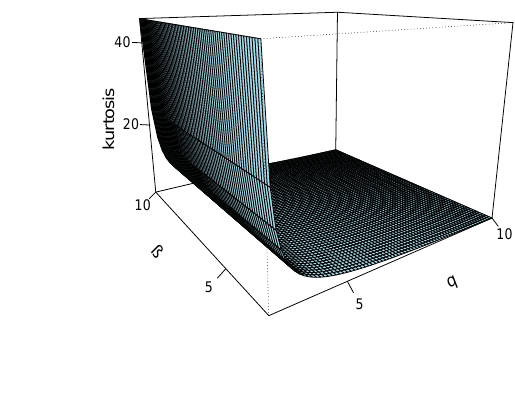
( c ) Plot of the asymmetry coefficients for the SPM model. ( d ) Plot of the kurtosis coefficients for the SPM model. Figure 4. Plots of the asymmetry and kurtosis coefficients for the PM and SPM models. Table 2. Asymmetry and kurtosis values for the SPM